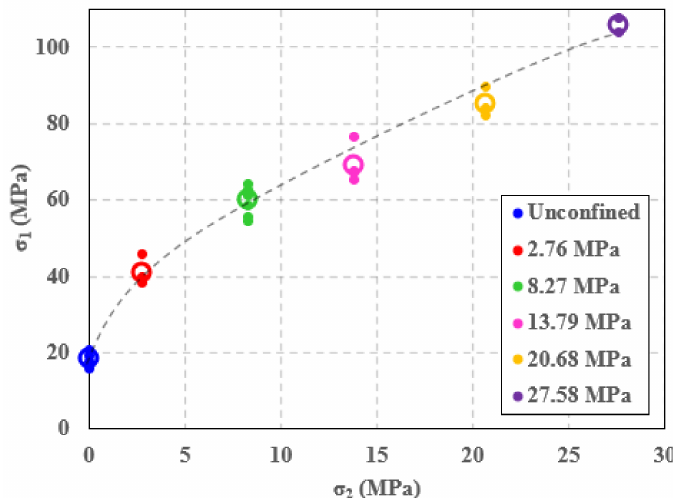
Figure 6. Intermediate and maximum principal stresses at failure for a series of confined, flattened Brazilian disks on sandstone. Average values at each confining stress, including unconfined, are represented by an open point. The dashed line represents the best fit failure curve.